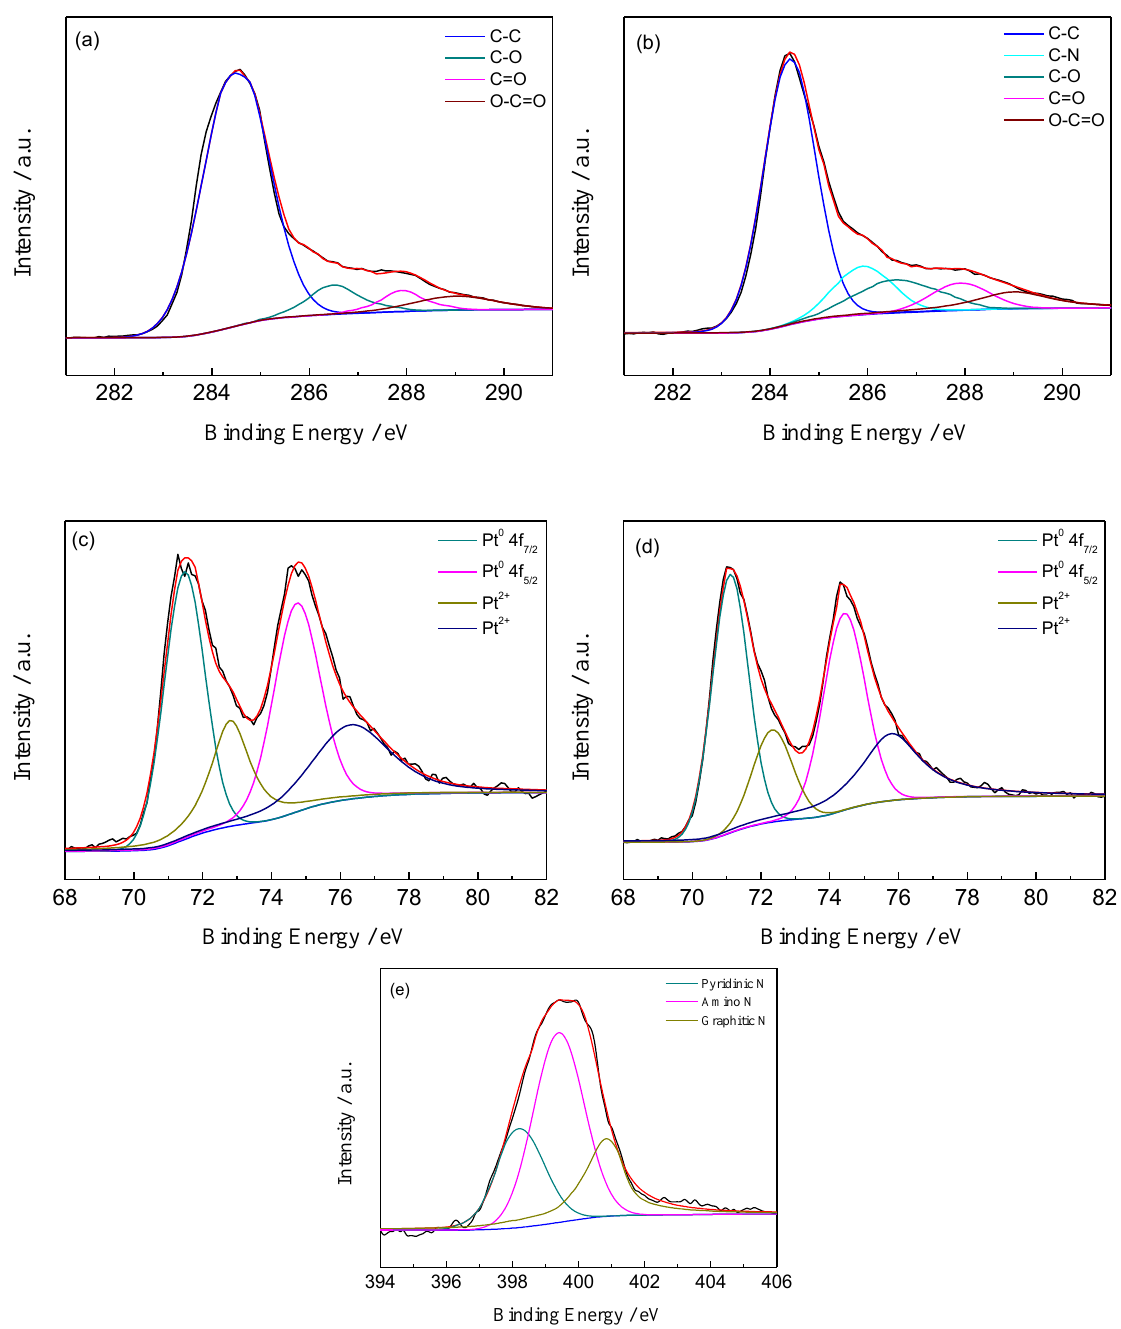
Figure 4. XPS spectra of catalyst 1#: ( a ) C 1s; ( c ) Pt 4f; XPS spectra of catalyst 6#: ( b ) C 1s; ( d ) Pt 4f; ( e ) N 1s. Table 1. XPS data and possible chemical compositions and states of N and Pt in the seven catalysts.